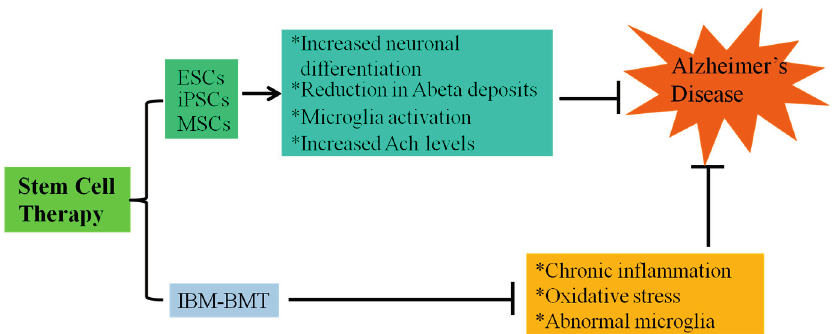
Figure 2. Summary of Stem Cell Therapy for